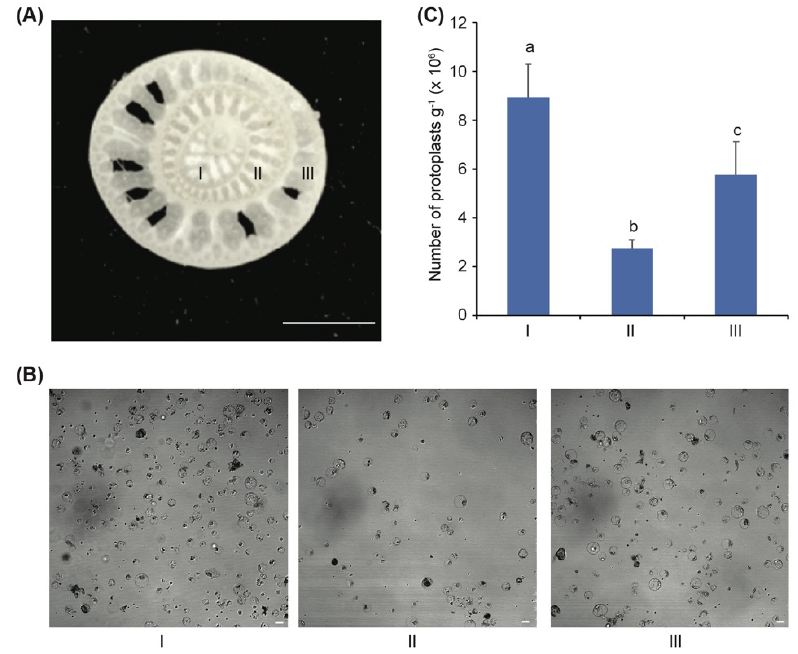
Figure 2. Yields of the protoplasts from different sheaths of the banana sucker. ( A ) After peeling off the outer layers of the banana sucker sheath, the most inner three layers ( I – III ) were prepared separately for protoplasts’ isolation. Bar = 1 cm. ( B ) The protoplasts isolated from different sheaths in ( A ) under bright field of microscope. Bars = 10 µ m. ( C ) The yields of protoplasts isolated from different sheaths in ( A ), after 6 h digestion in enzyme solution ES9. Y-axis represents the number of protoplasts per gram fresh weight ± SD ( n = 4). The different letters indicate statistically significant differences ( p < 0.05).